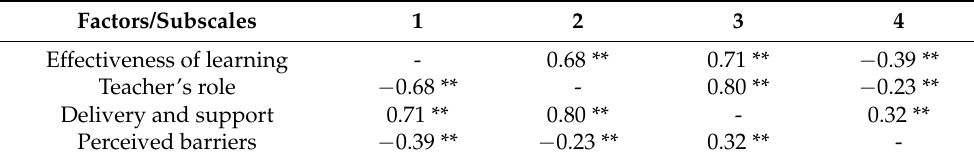
Table 3. Correlation matrix for the factors of the 3E-Scale. Factors/Subscales 1 2 3 4 Effectiveness of learning - 0.68 ** 0.71 ** − 0.39 ** Teacher’s role − 0.68 ** - 0.80 ** − 0.23 ** Delivery and support 0.71 ** 0.80 ** - 0.32 ** Perceived barriers − 0.39 ** − 0.23 ** 0.32 ** -